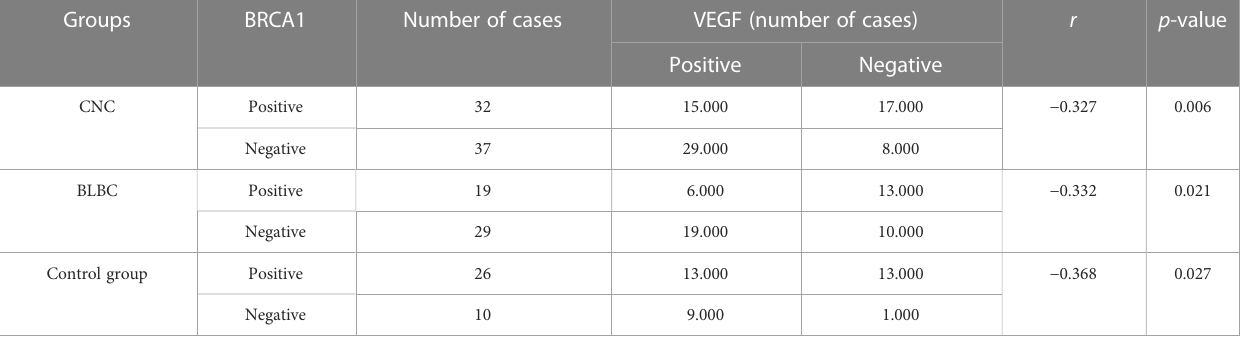
TABLE 6 Correlation analysis of BRCA1 and VEGF in CNC and BLBC and CNC and control group.